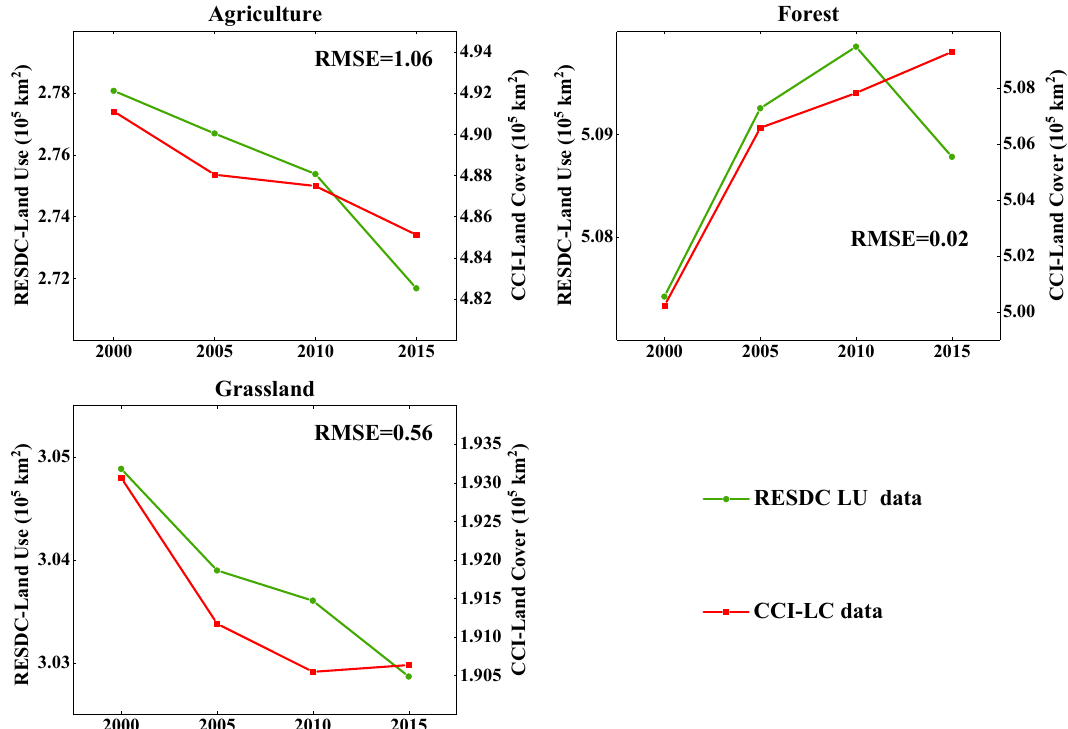
Figure 2. Consistency analysis of agricultural land, forest and grassland changes derived from the European Space Agency’s CCI-LC and the RESDC of the Chinese Academy of Sciences in 2000–2015.